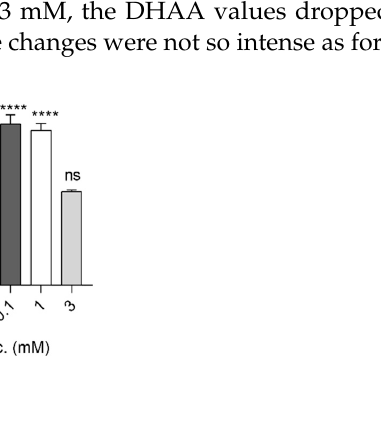
Figure 2. Ascorbic ( a ) and dehydroascorbic acids ( b ) concentrations in S. rebaudiana plants exposed to GB in concentrations of 0–3 mM. The concentrations are represented as mean and SD. (ns for p -value range > 0.05; * for p -value range 0.01–0.05; ** for p -value range 0.001–0.01; *** for p -value range 0.0001–0.01; **** for p -value range <0.0001).